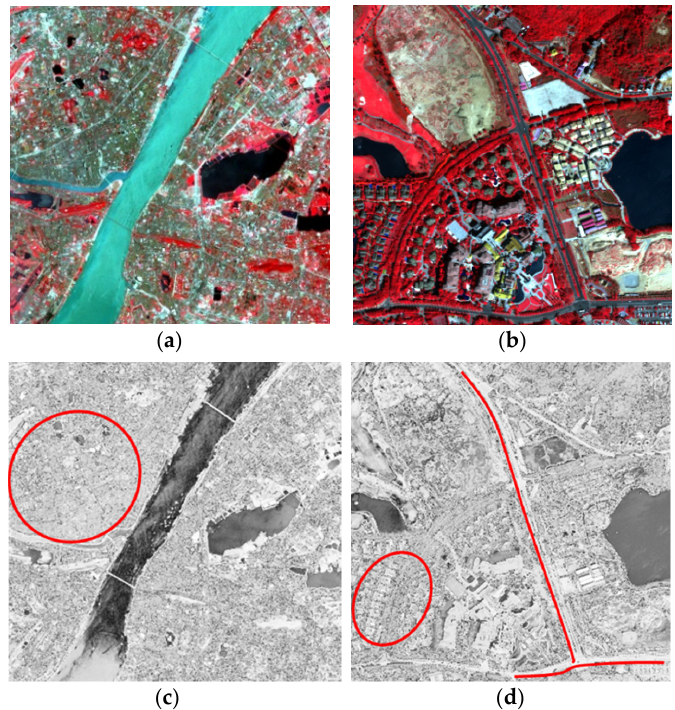
Figure 3. The weight parameter images of adaptive determination method (KADESFC) (circles and lines representing building and roads). ( a ) Wuhan TM image; ( b ) Fancun image; ( c ) the weight parameter image of Wuhan TM image; and ( d ) the weight parameter image of Fancun image.